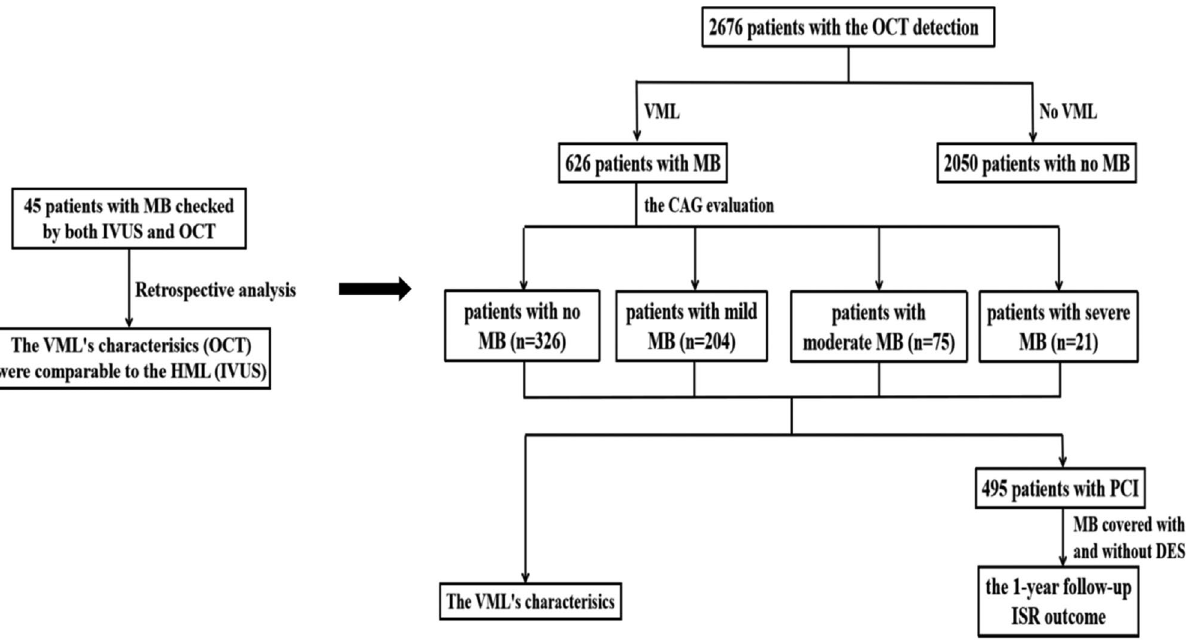
Figure 1. Work flow chart. MB myocardial bridge, IVUS intravascular ultrasound, OCT optical coherence tomography, VML visible muscle layer, HML half-moon layer, CAG coronary angiography, PCI percutaneous coronary intervention, ISR in-sent